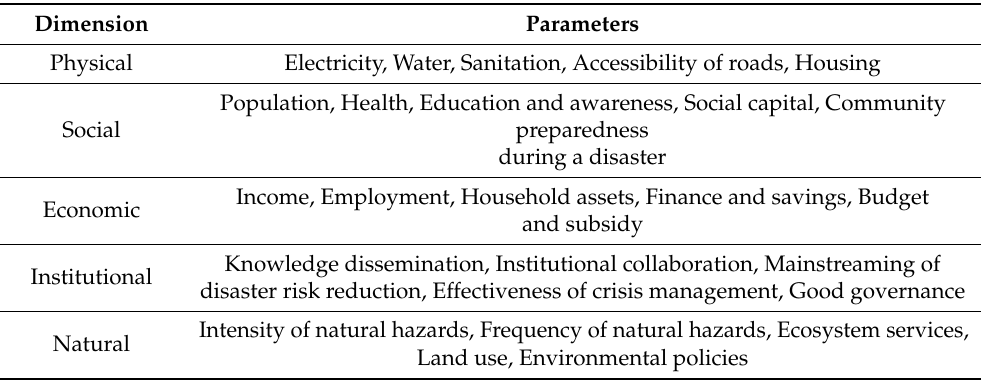
Table 1. List of variables considered in CDRI five dimensions.